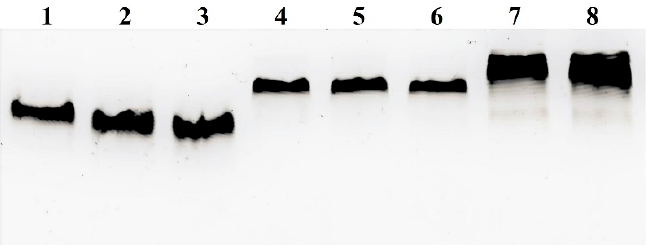
8, E1-W12. Lanes 1, 4 and 7 are samples before incubation; lanes 2 and 5 are 24-h incubation with serum; and lanes 3, 6 and 8 are 72-h incubation with serum.